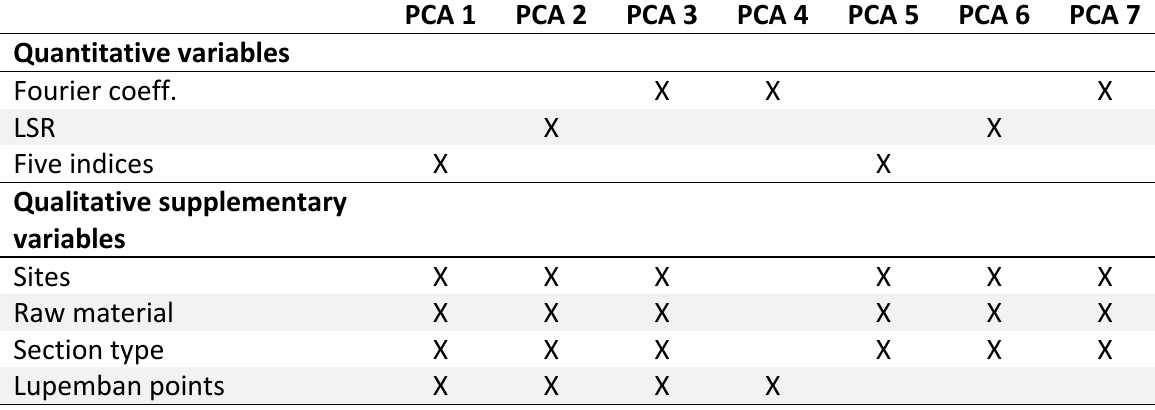
Table 2. Summary of the data sets (quantitative variables and qualitative supplementary variables) used for the seven PCAs realised in this paper. The crosses indicate the data sets used and the qualitative variables added. PC1 to PC4 include the whole assemblage. PC5 to PC7 include the Lupemban points only.